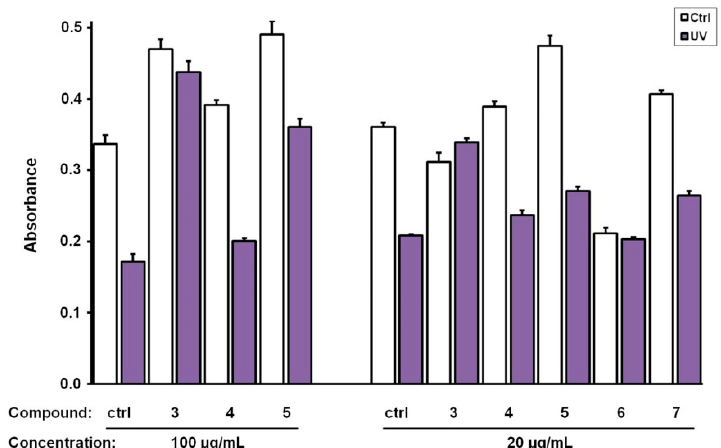
Figure 5. UV-protective capacity of the isolated compounds. The capacity of the isolated compounds to protect human skin fibroblasts from the lethal effects of UV-B-irradiation was assessed as described in the Materials and Methods. Results are expressed as absorbance values at 550 nm (reference wavelength 690 nm) and represent the mean of three independent experiments performed in quadruplicate.